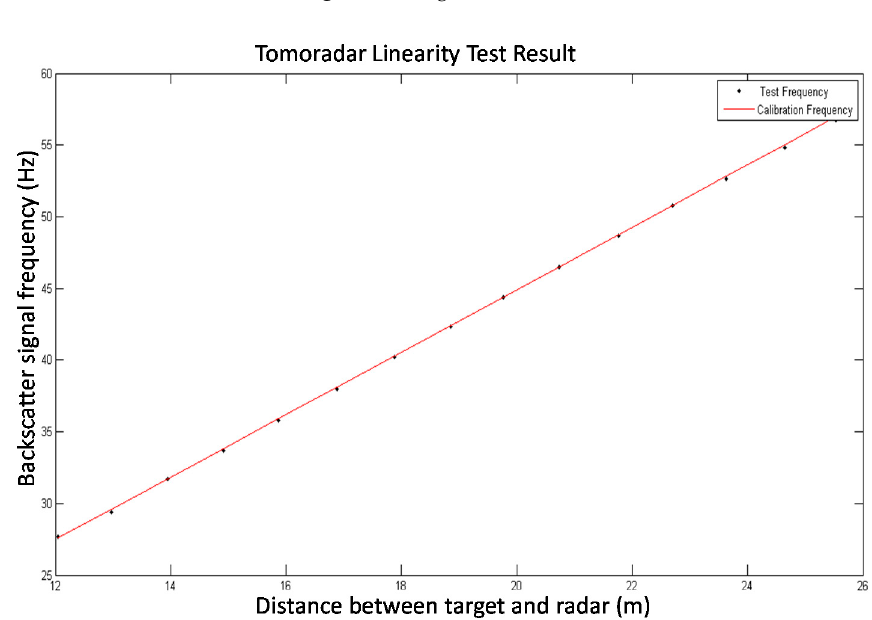
Figure 4. Range calibration results.